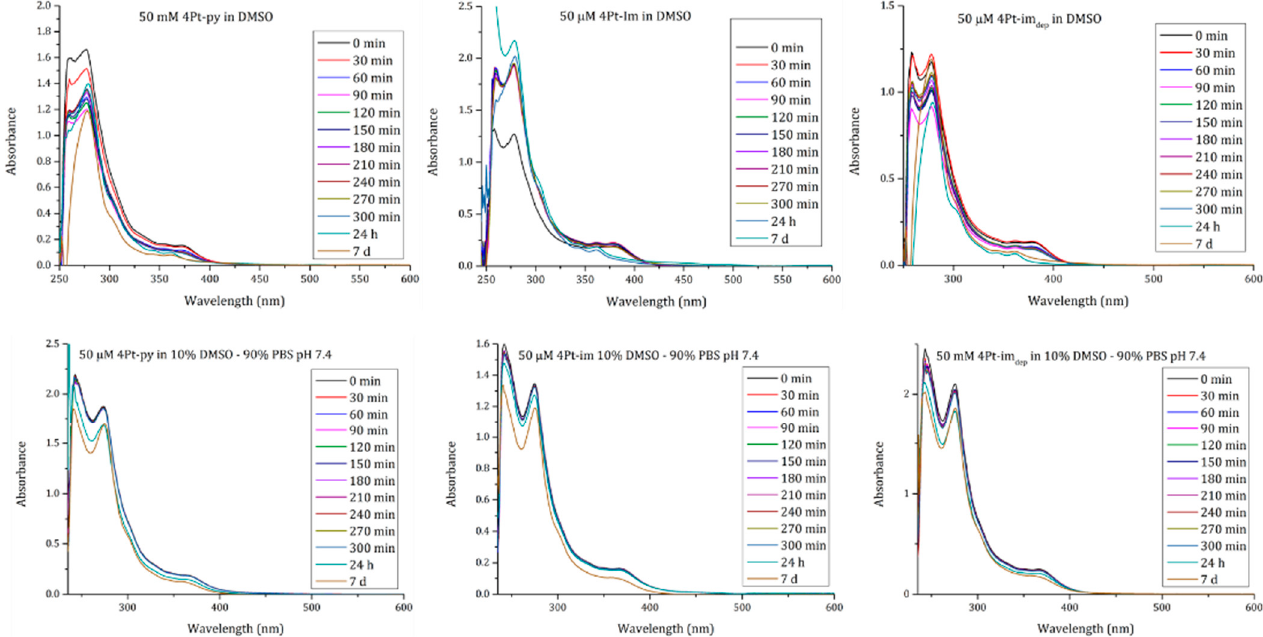
Figure 7. Time course UV–vis spectra of 50 μ M 4Pt-im , 4Pt-im dep , and 4Pt-py in PBS (pH 7.4):DMSO- d6 90:10 (down) and pure DMSO (up).